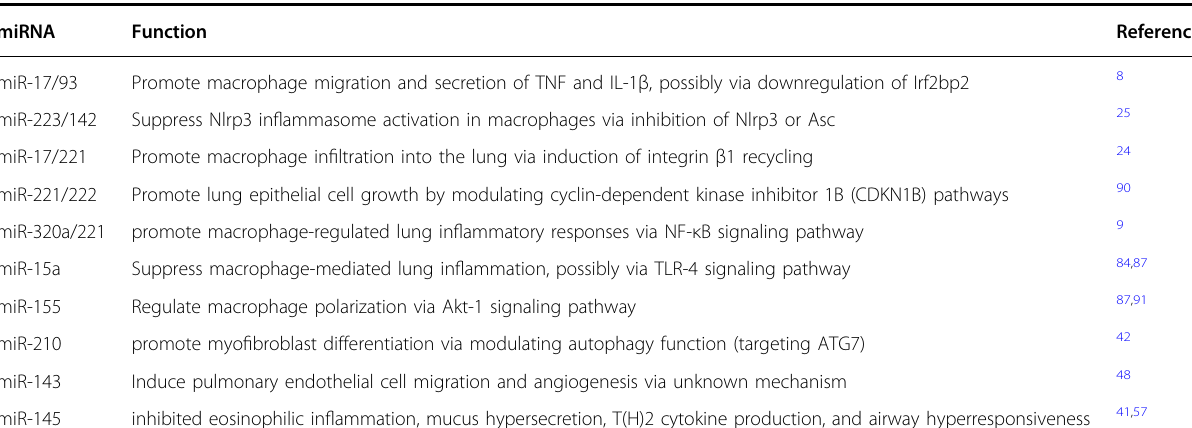
Table 2 List of EV-miRNAs in respiratory systems. miRNA